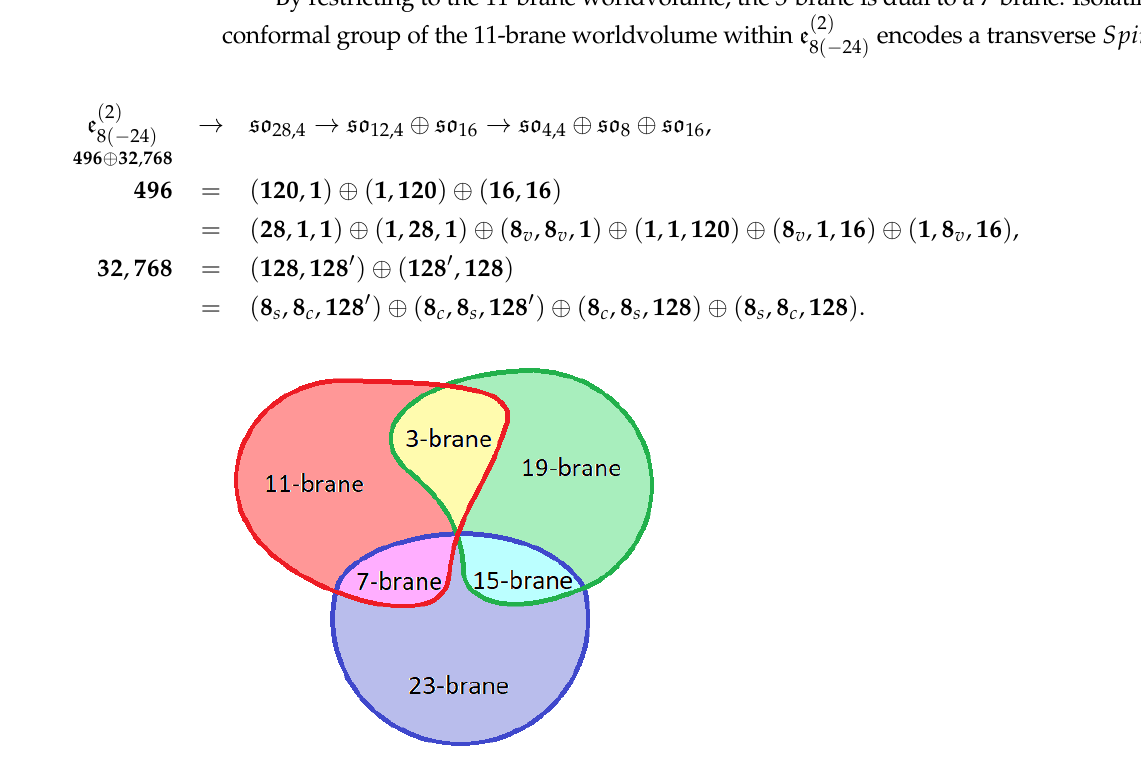
Figure 2. The intersections of branes in D = 27 + 3. For instance, the 3-brane is dual to the 23-brane, which contains the 7-brane and